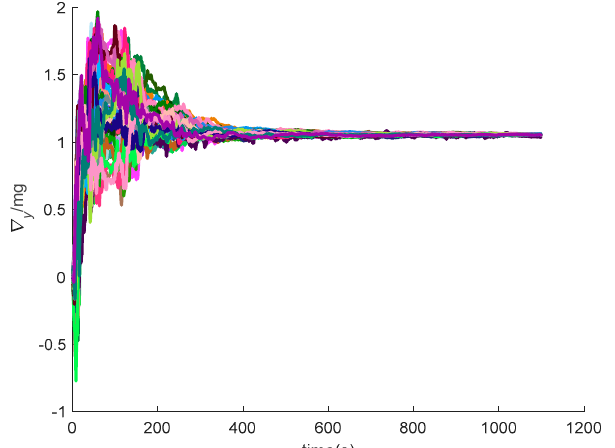
Figure 29. The y -axis accelerometer constant bias of SINS/GPS in the LCEF frame.